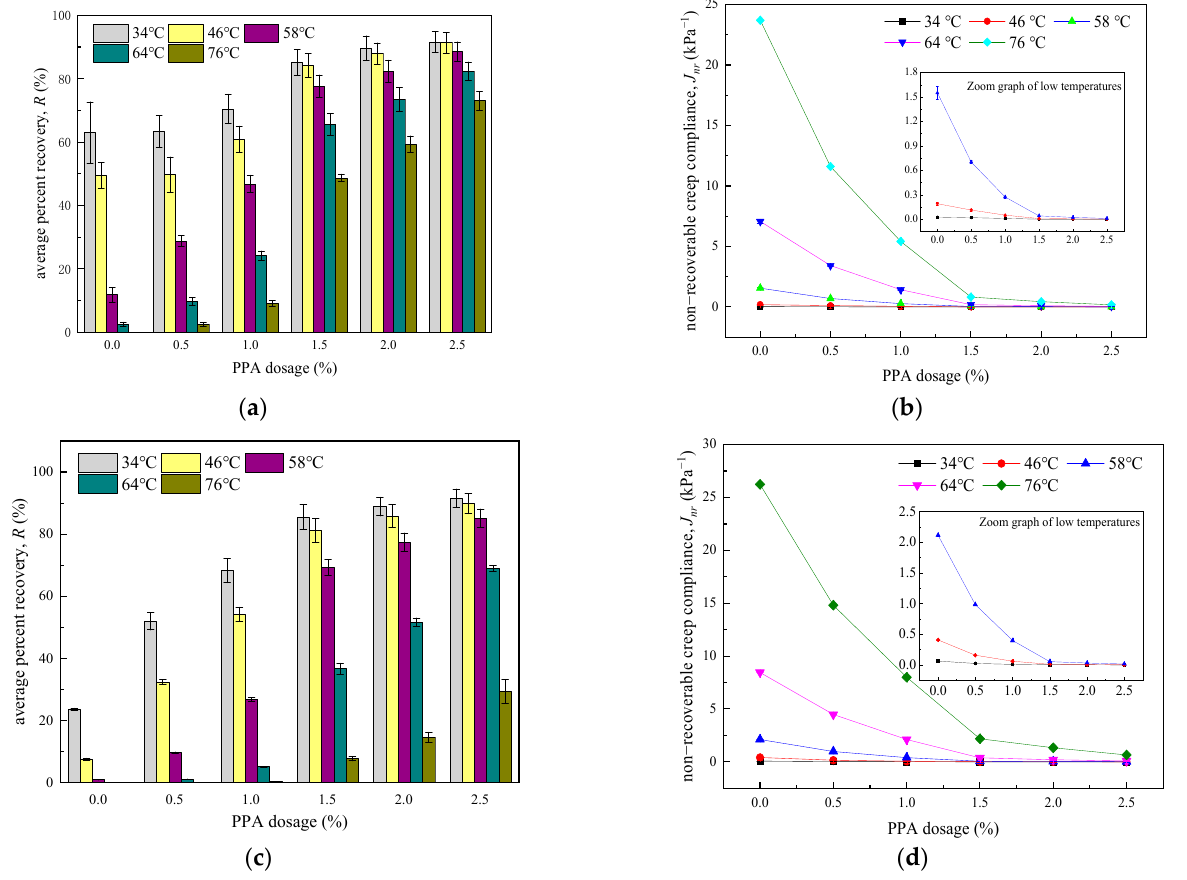
6 of 20 In Figure 3, 𝐸 (cid:2869) and 𝜂 (cid:2869) from Kelvin model, Pa and Pa·s; 𝐸 (cid:2870) is an elastic element rep- resenting the instantaneous elastic deformation, Pa; 𝜂 (cid:2870) is a single viscous element, Pa·s. Thus, the creep stage of PPA-modi fi ed asphalt binders can be described by: 𝜀(t) = 𝜎 (cid:2868) 𝐸 (cid:2869) × (cid:3436)1 − 𝑒 (cid:2879)(cid:3006) (cid:3117) (cid:3086) (cid:3117) × (cid:3047) (cid:3440) + 𝜎 (cid:2868) 𝜂 (cid:2870) × 𝑡 (7) If Bol tz mann superposition principle applies, the recovery stage can be described as: 𝜀(t) = 𝜎 (cid:2868) 𝐸 (cid:2869) × (cid:3436)1 − 𝑒 (cid:2879)(cid:3006) (cid:3117) (cid:3086) (cid:3117) × (cid:3047) (cid:3117) (cid:3440) × 𝑒 (cid:2879)(cid:3006) (cid:3117) (cid:3086) (cid:3117) × ((cid:3047)(cid:2879)(cid:3047) (cid:3117) ) + 𝜎 (cid:2868) 𝜂 (cid:2870) × 𝑡 (cid:2869)